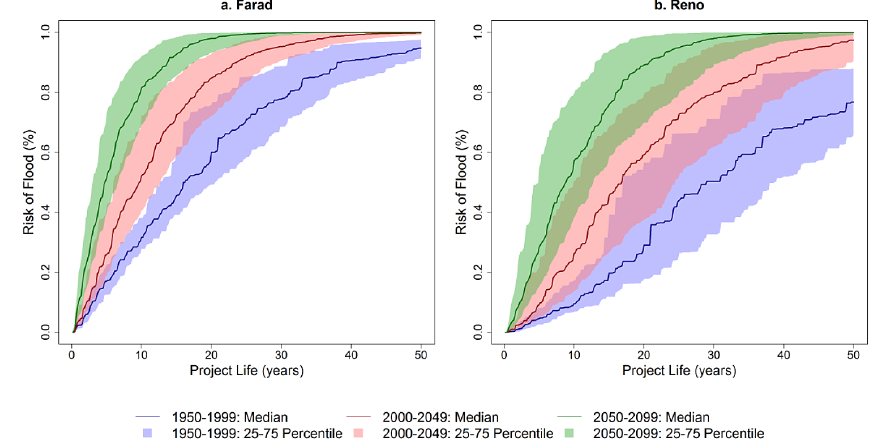
Figure 5. Probability of 1-day flood exceeding historical maximum of 1065cms (risk) at Farad and Reno. Solid lines represent the median risk of the 234 climate projections and shading covers the interquartile range (i.e., 25th to 75th percentile).